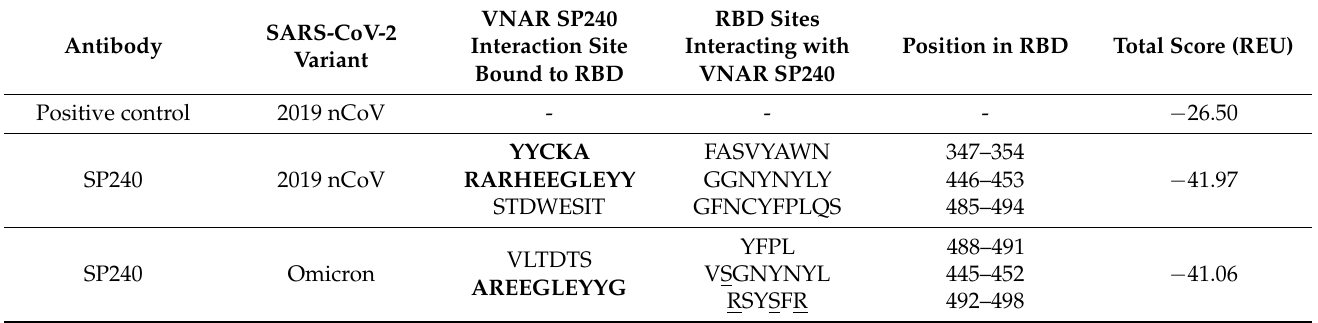
Table 1. Interaction values of the RBD-VNAR interaction. The amino acids in the CDR3 loop that participate in the interaction are shown in bold. Mutated amino acids in the spike (S) protein are